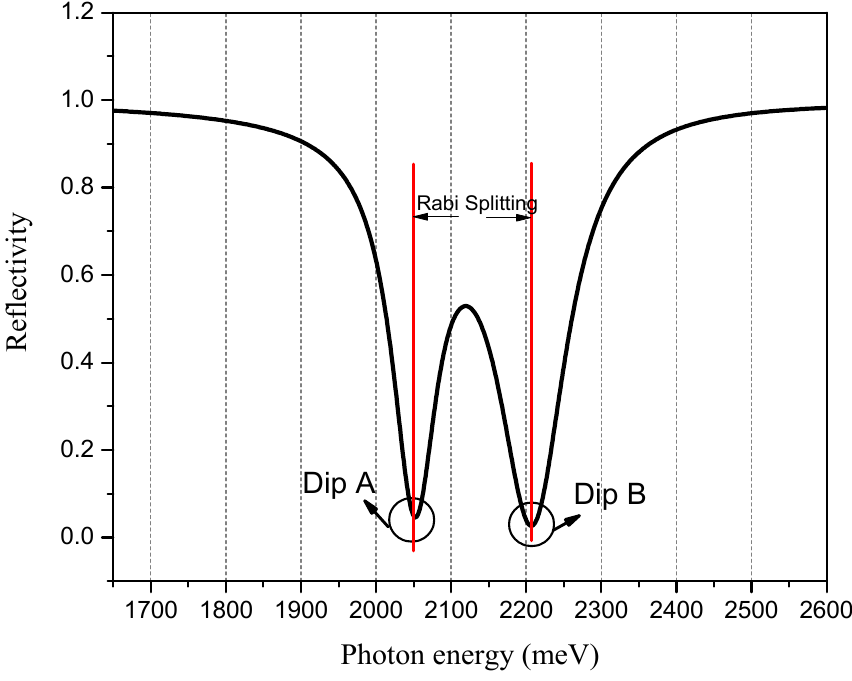
Figure 2. The strong coupling effect between SPP and TDBC excitons. The thickness of the Ag film is 42 nm, and the incident angle of excitation light is 49°.